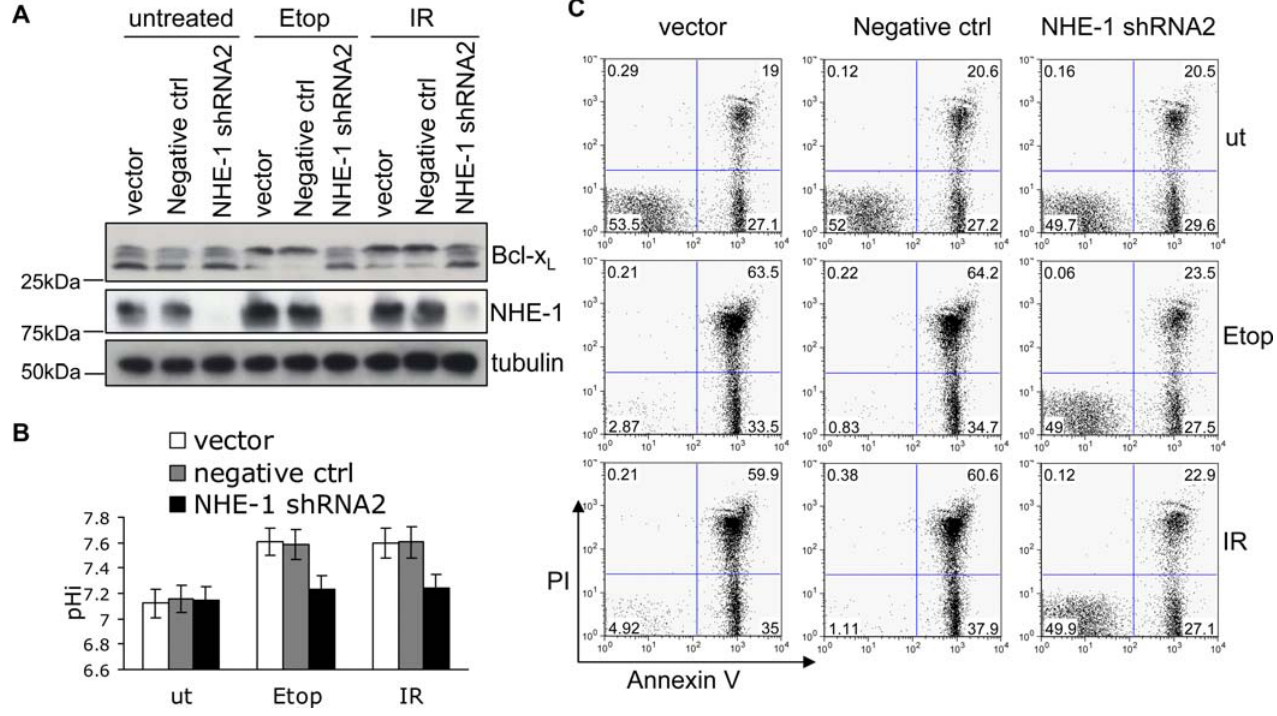
Figure 5. NHE-1 Knockdown Blocks DNA Damage–Induced Bcl-x L Deamidation and Apoptosis (A) Empty vector, negative control, or NHE-1shRNA2 were transduced into wild-type thymocytes, then treated with Etoposide (Etop) or irradiation (IR) prior to immunoblotting for NHE-1 and Bcl-x L . (B) Aliquots of the cells from (A) were analysed for pH i . The histogram represents mean values 6 SD ( n ¼ 3). (C) Aliquots of the cells from (A) were analysed for apoptosis by Annexin V/PI staining using flow cytometry, as illustrated in a representative experiment (total n ¼ 5). The numbers shown are the percentage of cells in each quandrant. Histograms summarising the percentage of apoptotic cells (Annexin V þ PI (cid:1) ) and dead cells (Annexin V þ PI þ ) are shown in Figure